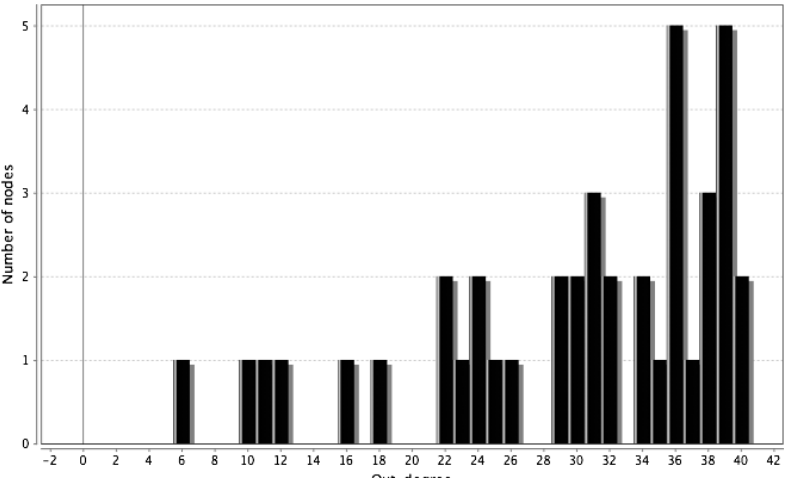
Figure 10. In-degree (A) and out-degree (B) distribution of the members in the Books relations network. Characteristics of the Conversations Established in Twitter